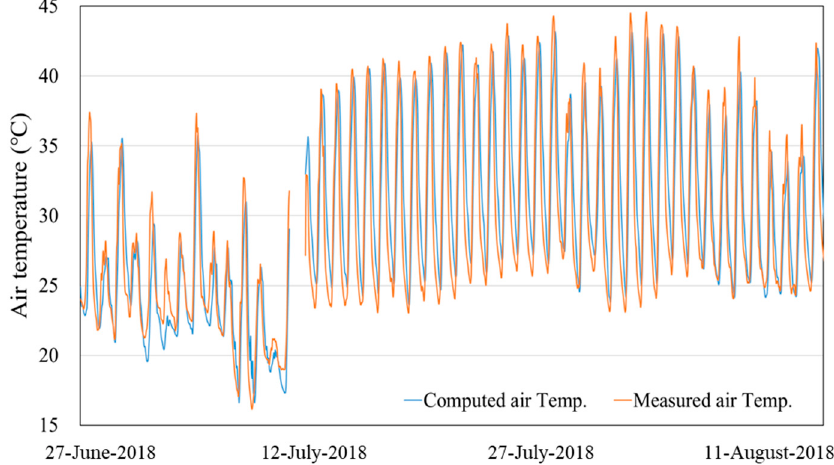
Figure 13. Validation between BES-computed and field-measured air temperatures ( ◦ C).